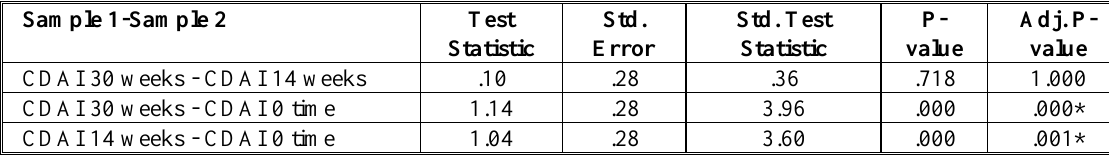
Table 6-B. Pairwise comparisons